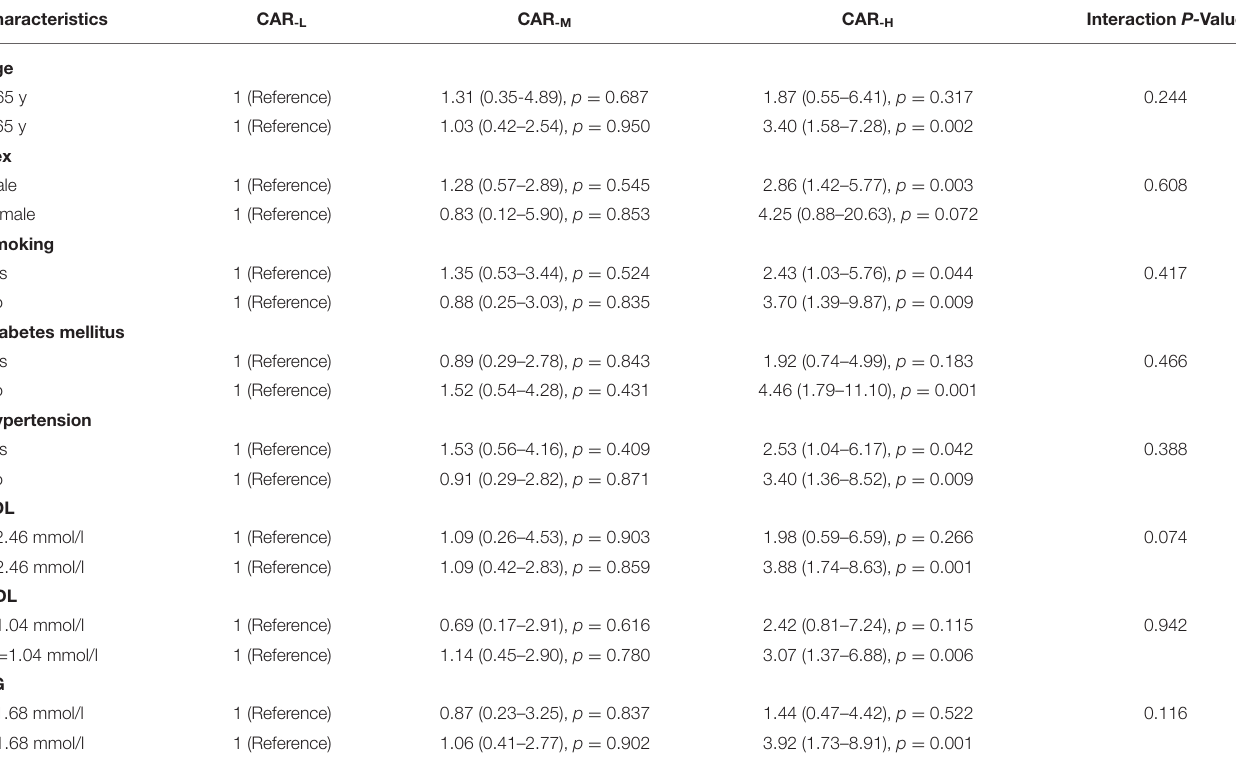
TABLE 3 | CAR level and risk of all-cause death of CTO-PCI patients, stratified by various baseline characteristics. Characteristics